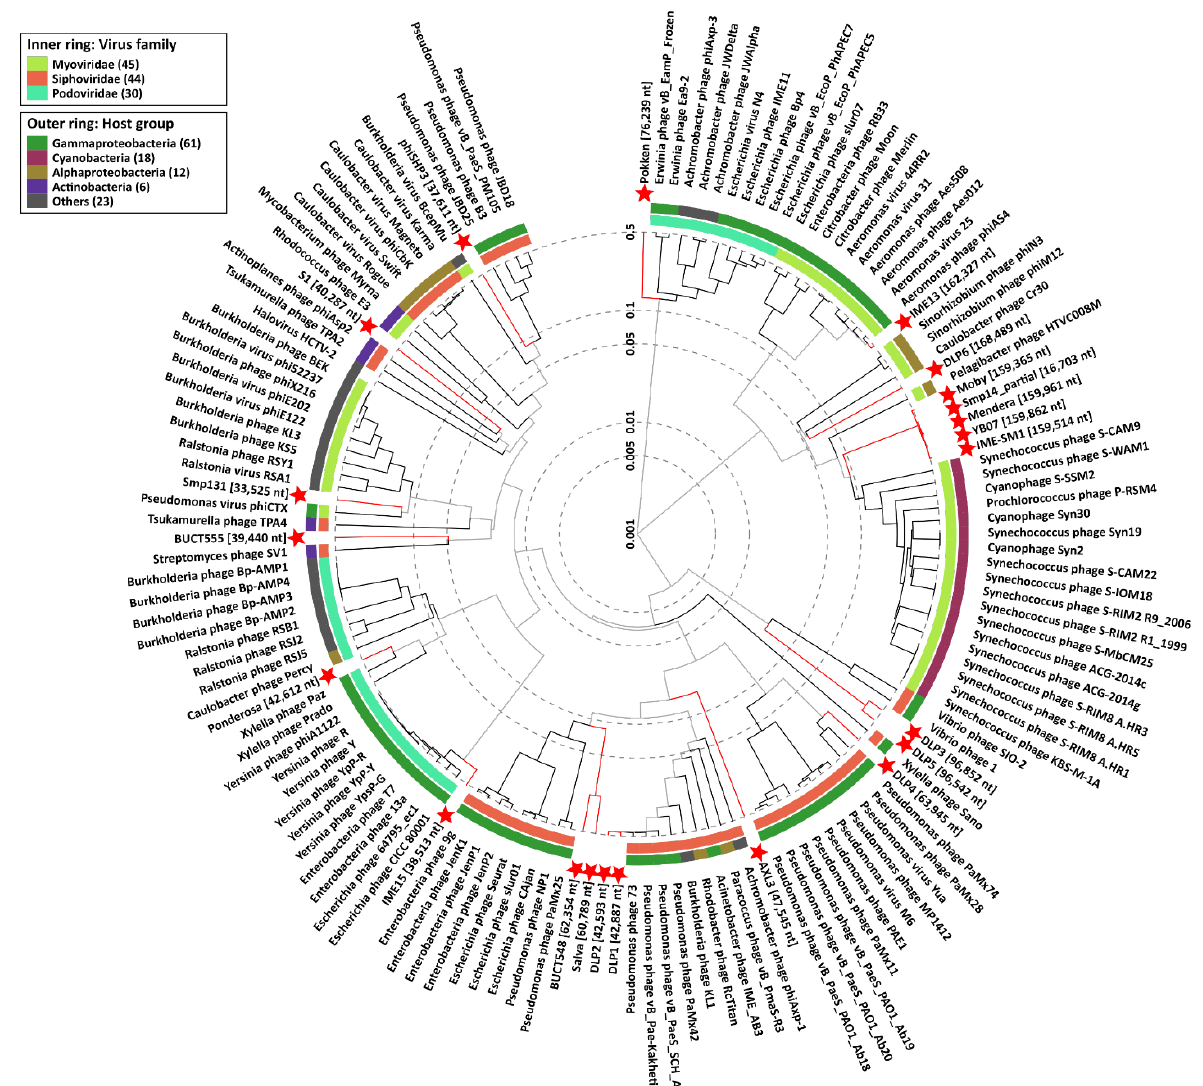
Figure 4. S. maltophilia phage phylogenetic tree. The results of ViPTree analysis using a protein distance metric based on normalized tBLASTx scores plotted on a log scale. The tree includes 142 dsDNA phages with the 22 S. maltophilia phages with genome sequencing data highlighted with red stars. Related phages chosen for inclusion were selected as the top ten phages with the highest genome similarity S G scores for each of the 22 S. maltophilia phages with sequencing data available. This tree was generated using the ViPTree server